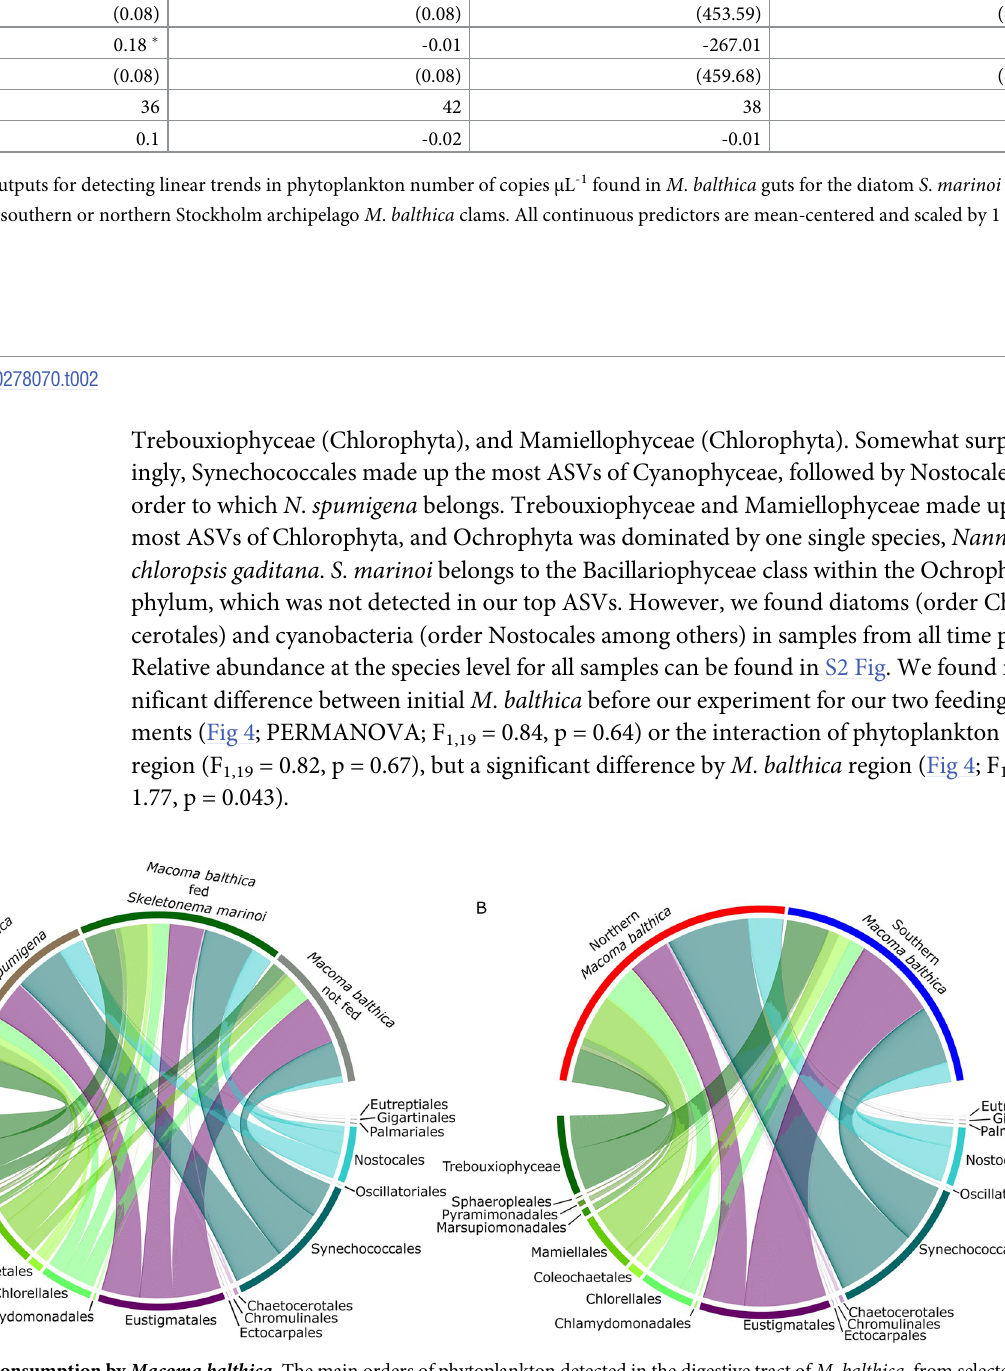
Fig 3. Phytoplankton consumption by Macoma balthica . The main orders of phytoplankton detected in the digestive tract of M . balthica , from selected samples sequenced after 23S rRNA gene metabarcoding, divided by phytoplankton fed (A; cyanobacteria Nodularia spumigena (brown), diatom Skeletonema marinoi (green), or not fed (gray)) and region (B; northern (red) and southern (blue) Stockholm archipelago). The size of the colored lines denotes the relative abundance (%) of the various taxa detected in the digestive tract of M . balthica